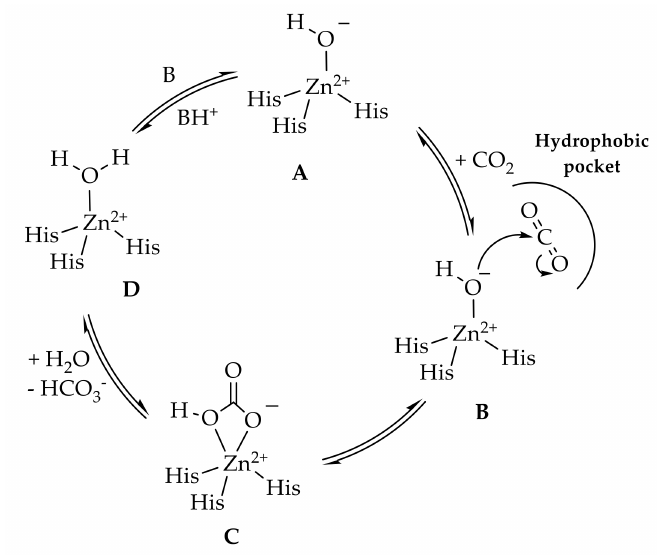
Figure 2. Schematic representation of the hCA catalytic